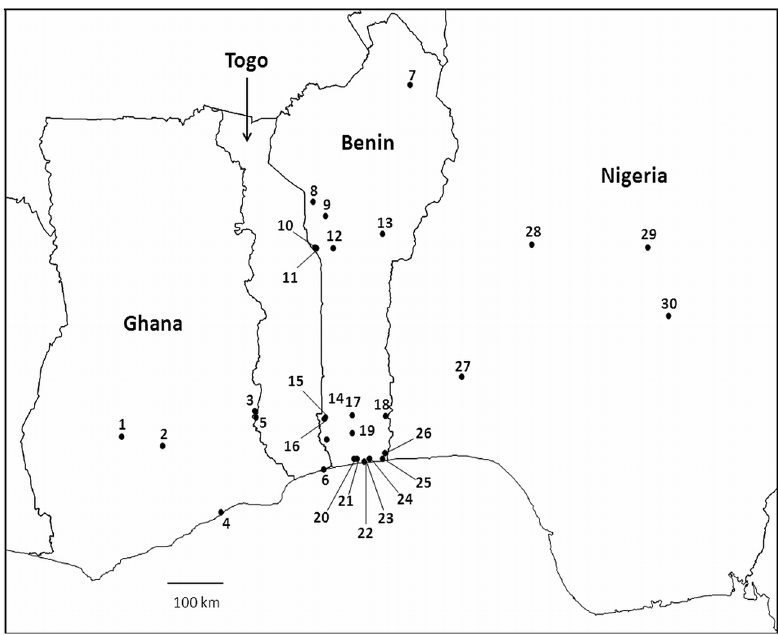
Fig 1. Map of the Central African region where hoverflies were collected (Ghana — Togo — Benin — Nigeria), showing the sampling localities (for more details see the S1 Table).